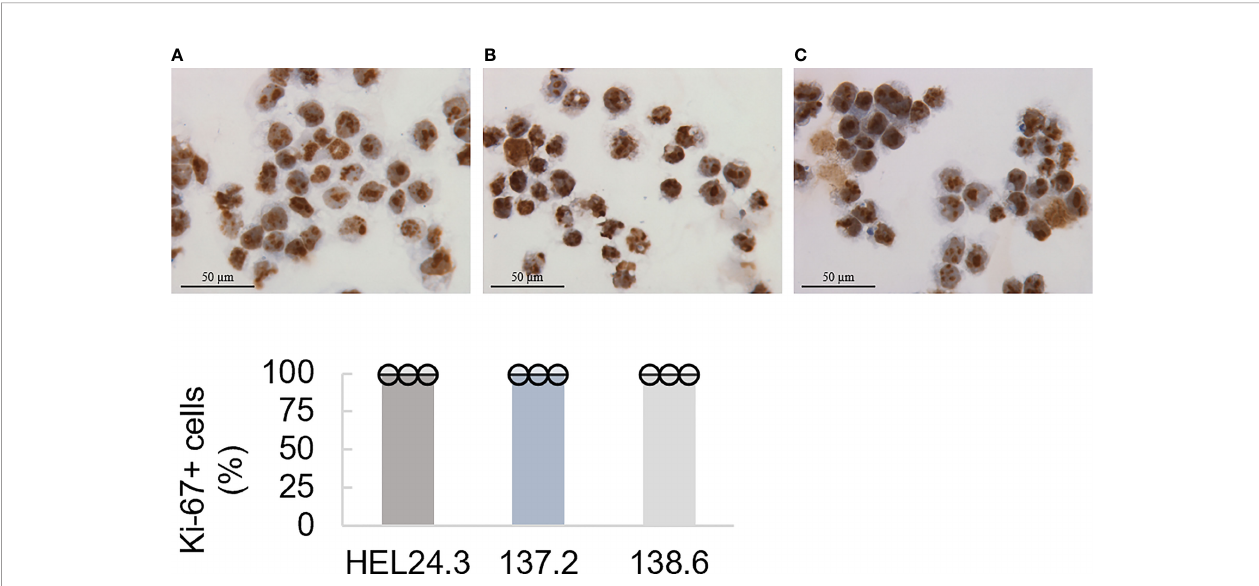
FIGURE 1 | Proliferation capacity of APECED patient-derived iPSCs. Top panel: The healthy control iPSCs HEL24.3 (A) and APECED iPSCs 137.2 (B) and 138.6 (C) display similar Ki-67 positivity. Bottom graph: Quantitation of proliferation (Ki-67+) in the iPSCs reveals they are similar irrespective of AIRE mutation. Dots represent three individually performed replicates, with error bars representing SD within a replicate. Bar graphs are the mean of three replicates, with error bars representing SEM of the replicates. No difference was observed between the cell